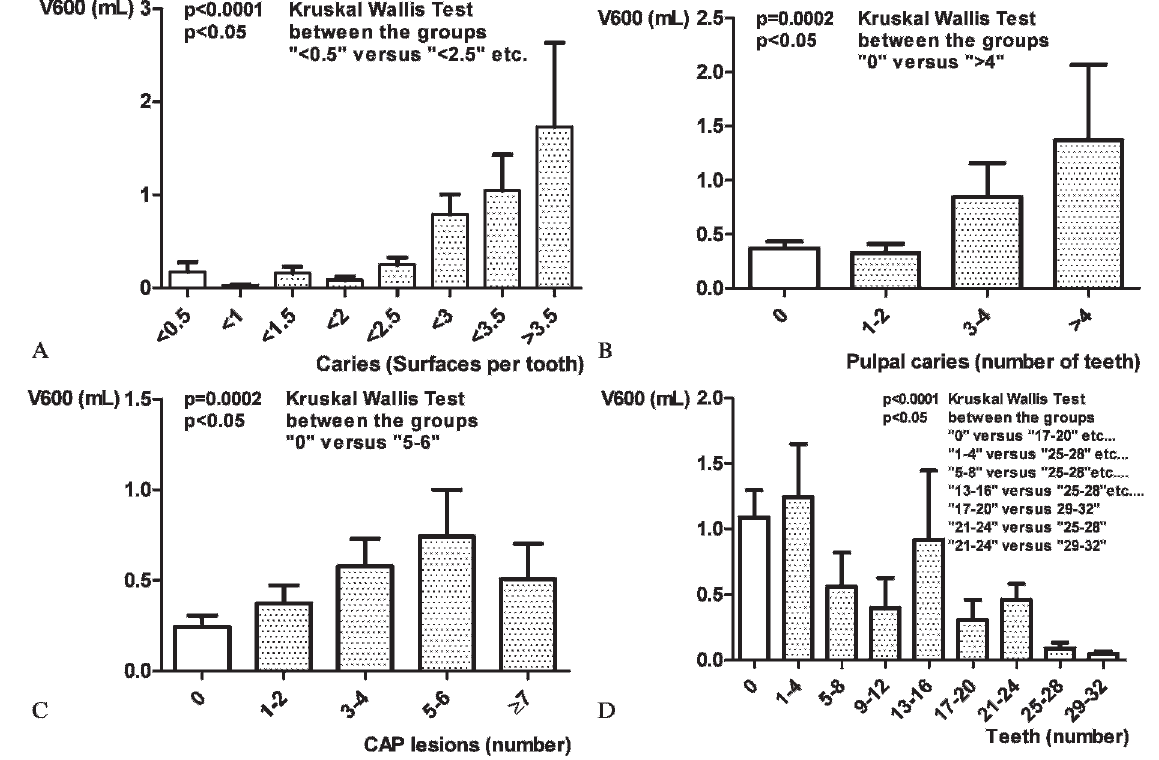
Figure 3 - A) Correlation between the aortic atherosclerotic burden (axis of ordinates, in milliliters) and caries (axis of abscissa, surfaces per tooth). B) Correlation between the aortic atherosclerotic burden and pulpal caries. C) Correlation between the aortic atherosclerotic burden and chronic apical periodontitis (CAP). D) Correlation between the aortic atherosclerotic burden and the number